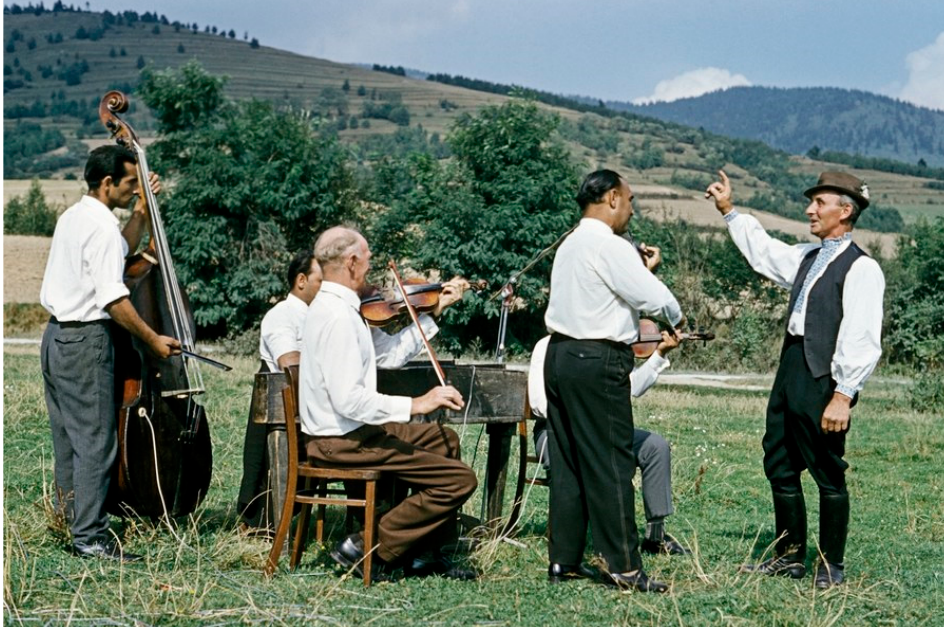
Figure 4. Szabó, Tibor: Folk Music from Slavošovce (©1993–2020 Internet Public Access - Cosmotron Slovakia, s.r.o.) against a background containing plots of the traditional agricultural landscape.